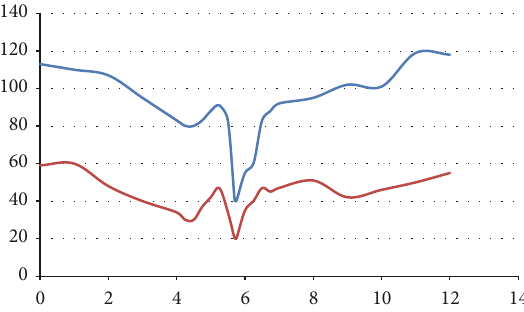
Figure 1: Patient’s blood pressure measurements over the time (hours) since arrival to the emergency department. Systolic blood pressure measurements are displayed above diastolic blood pressure